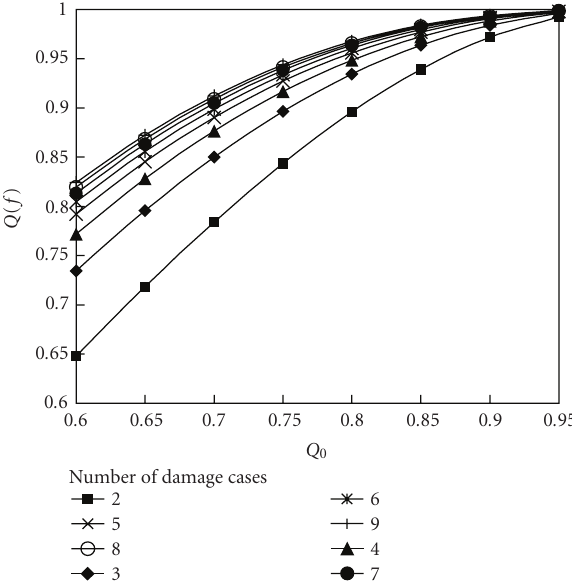
Figure 4: PCS of system versus that of sub-decision system, number of sub-decisions is